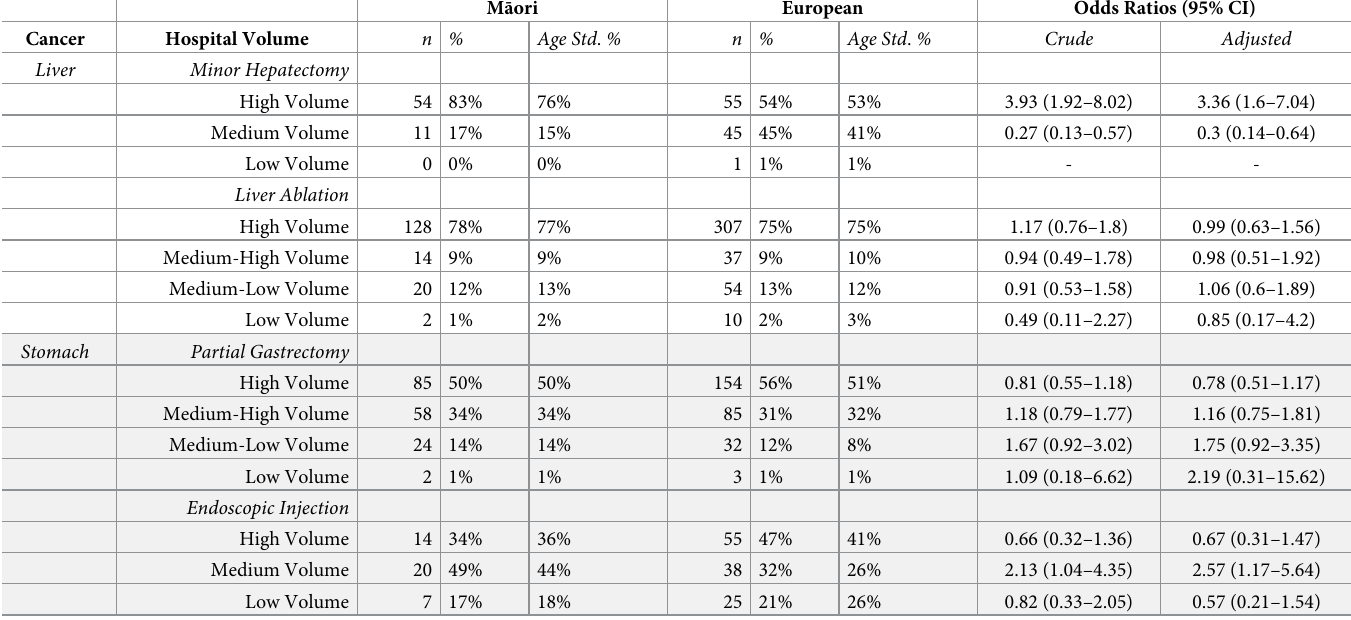
Table 3. Comparison of place of surgery according to hospital volume between M ā ori and European patients for selected surgeries. M ā ori European Odds Ratios (95% CI)